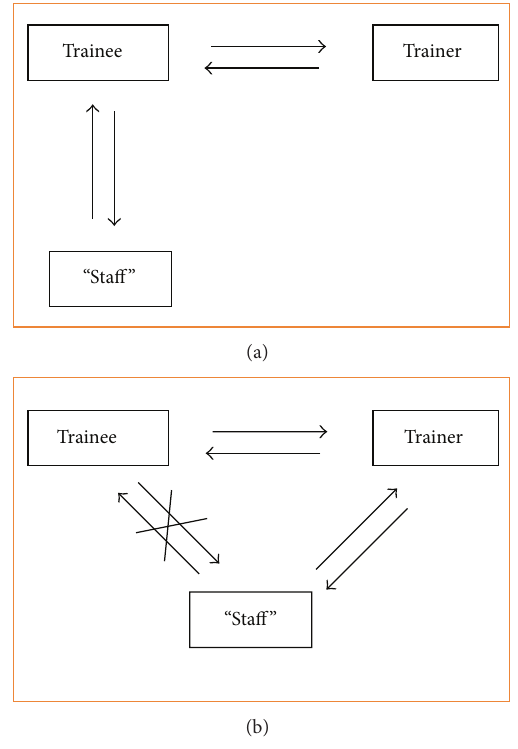
Figure 1: In scenario (a), the trainee visits the trainer. The trainee has to answer all the questions and work with the skepticism from his department/staff when he gets back to his own workplace. In scenario (b), the situation is different because the trainer is present at the trainees department where he/she can answer questions, thus relievingthetraineeandallowinghim/hertofocusonthetechnique.